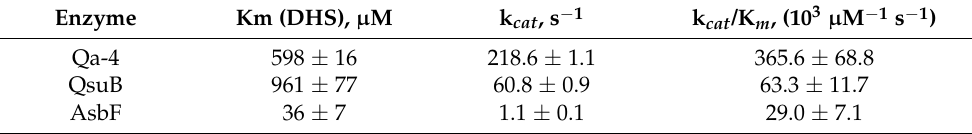
Table 3. Catalytic properties of DSDs (pH 7.5, 20 °C).